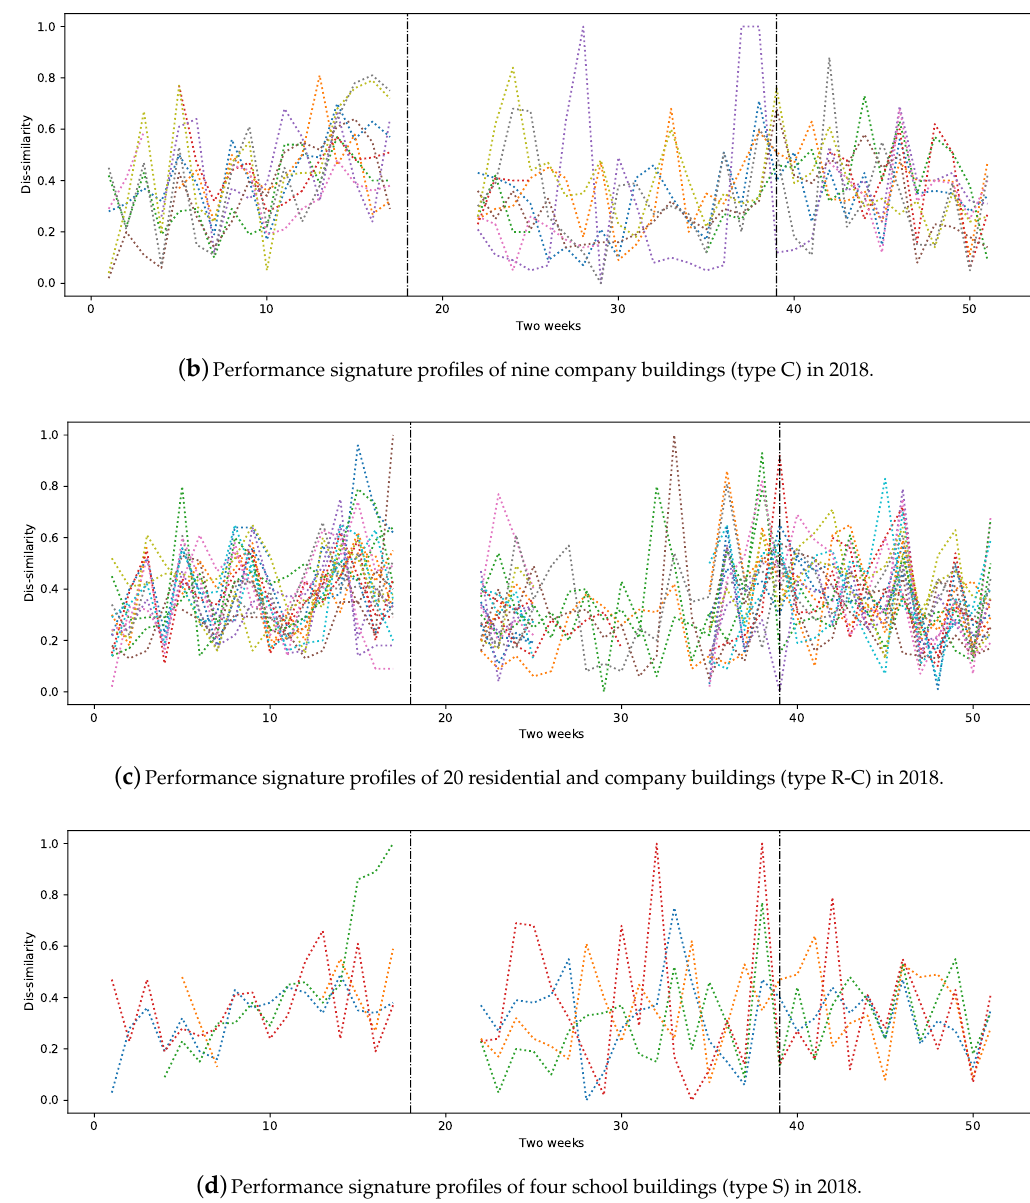
Figure 2. Performance signature profiles of substations based on building types. Due to missing values, some of the bi-weekly comparisons are missing. The area between two vertical dashed lines in each plot represents the non-heating season. In all of the above plots, each color represents a performance signature profile of a